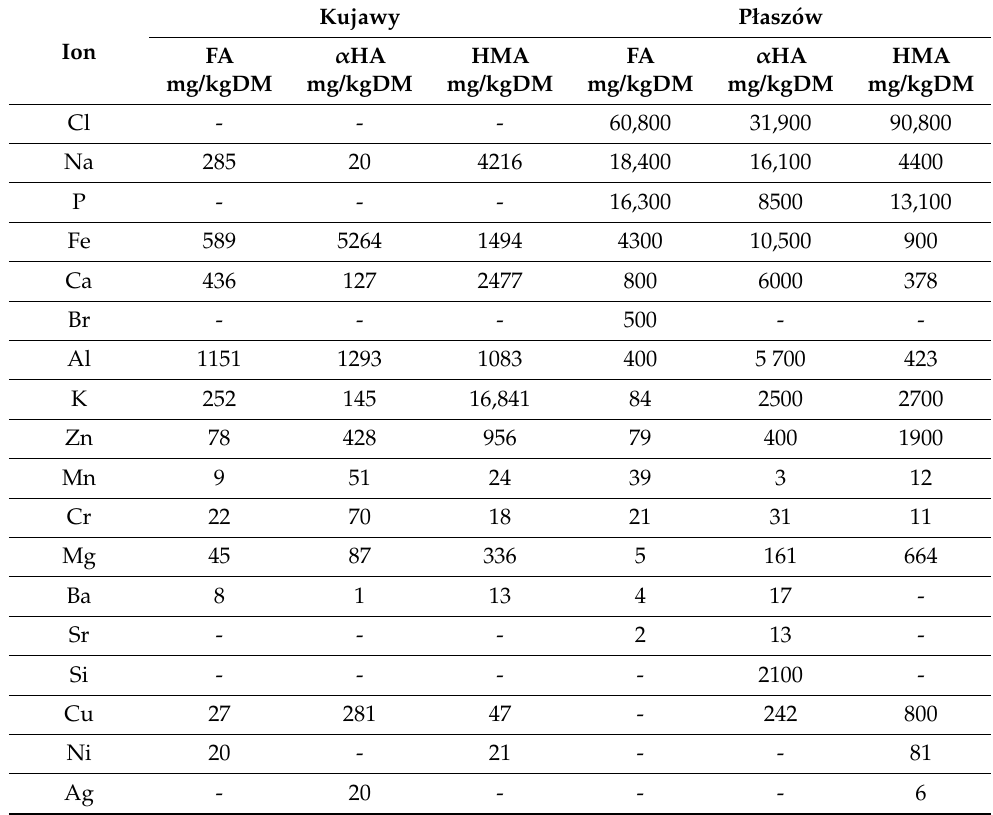
Table 4. Micropollutants of humus acids extracted from digested sludge from the Kujawy and Płasz ó w wastewater treatment plants.